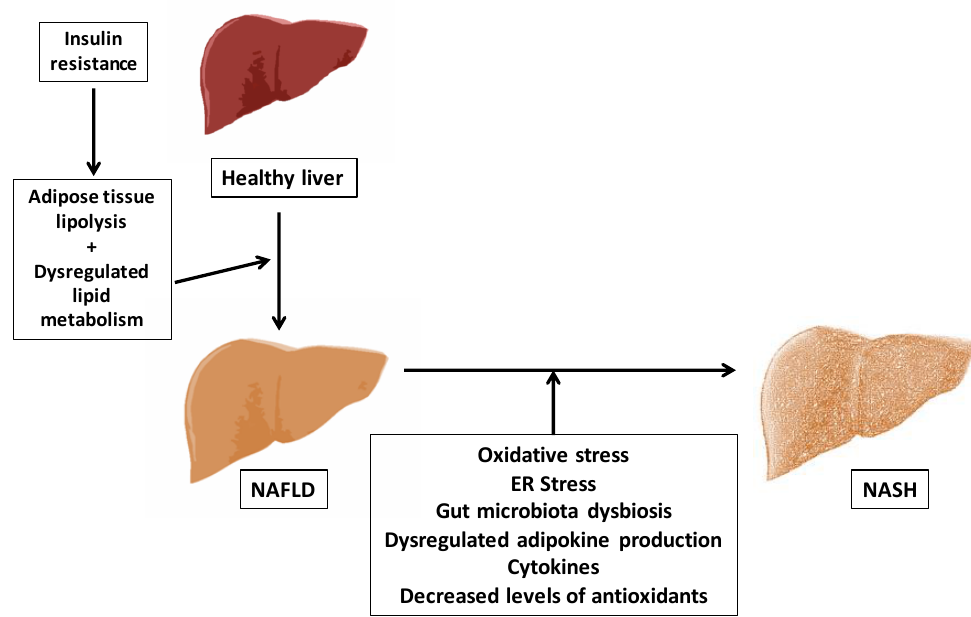
Figure 1. Multiple parallel hits NAFLD pathogenesis model. Non-alcoholic fatty liver disease (NAFLD). Non-alcoholic steatohepatitis (NASH). Endoplasmic reticulum (ER).